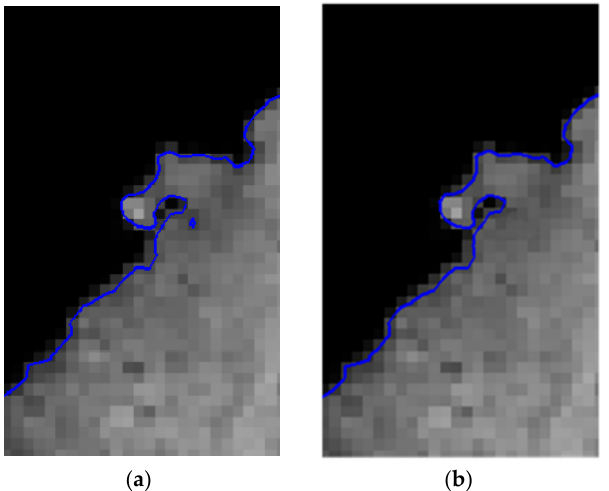
Figure 12. Comparison of partial block tracking: ( a ) Before block tracking ( b ) After block tracking.